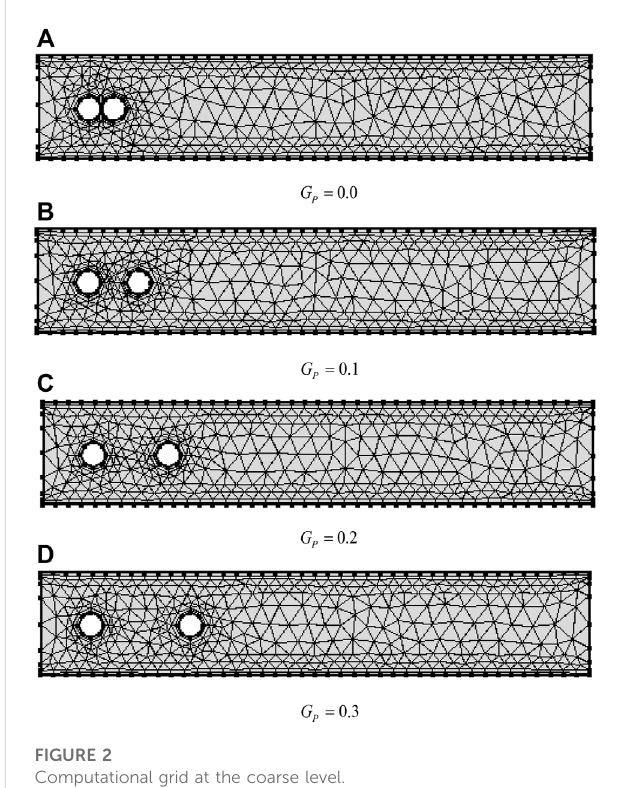
FIGURE 2 Computational grid at the coarse level.